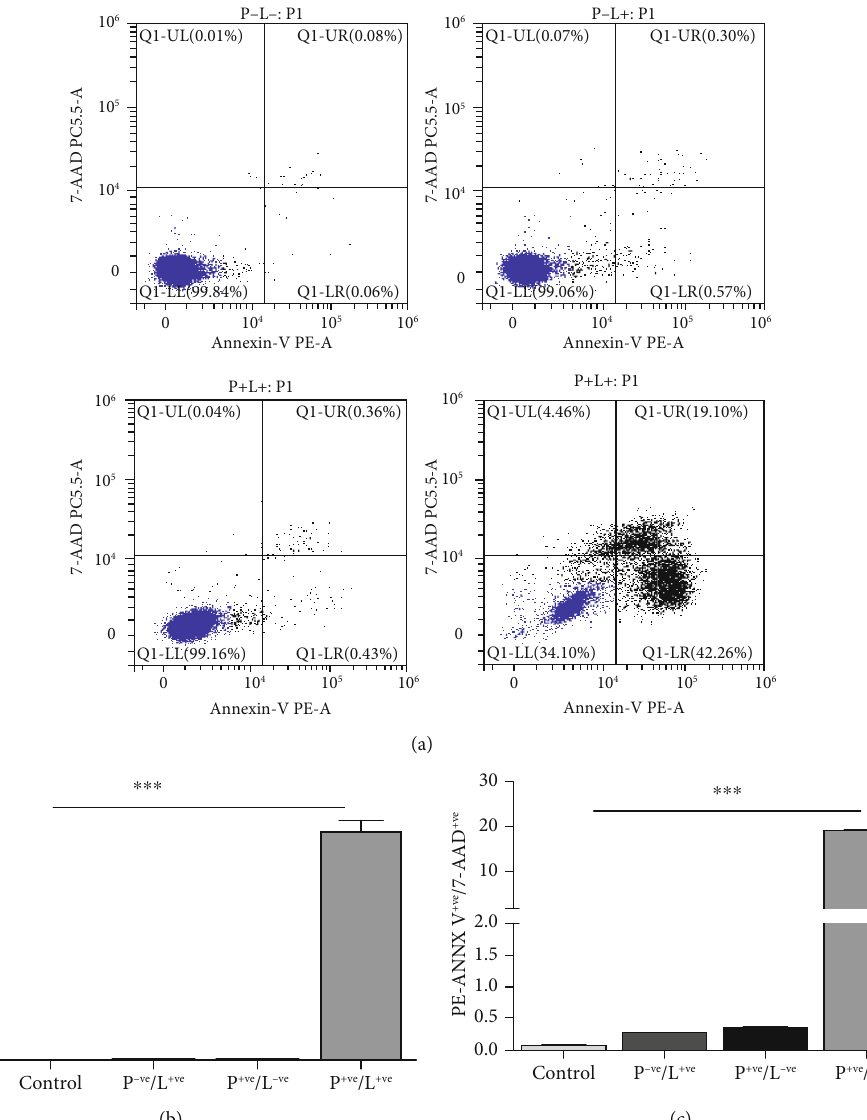
Figure 4: AE-mediated PDT consequences on cell apoptosis obtained through PE. (a) Annexin V/7-AAD staining and fl ow cytometry. Percentage graphical representation of PE-Annexin V positive cells ’ (b) early apoptosis and (c) overall apoptosis. The data show means ± SD of three independent assays ( ∗∗∗ p < 0 : 0001 ). Control (P-L-), light irradiation only (P-L+), AE only (P+/L-), and AE-mediated PDT (P+L+),